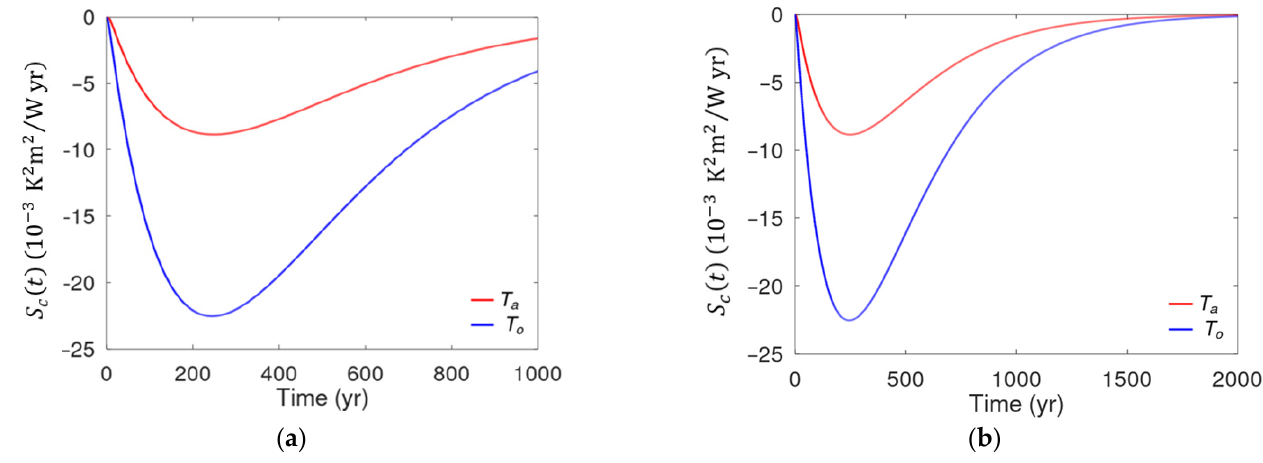
Figure 3. Sensitivities of global mean surface temperature (red line) and global mean deep ocean temperature (blue line) anomalies with respect to parameter C o , calculated for step-forcing: ( a ) over time interval of 0–1000 years, ( b ) over time interval of 0–2000 years.